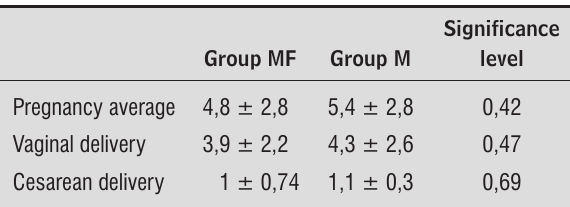
Table 2 - Characterization of the number of pregnancies and obstetric background Significance Group MF Group M